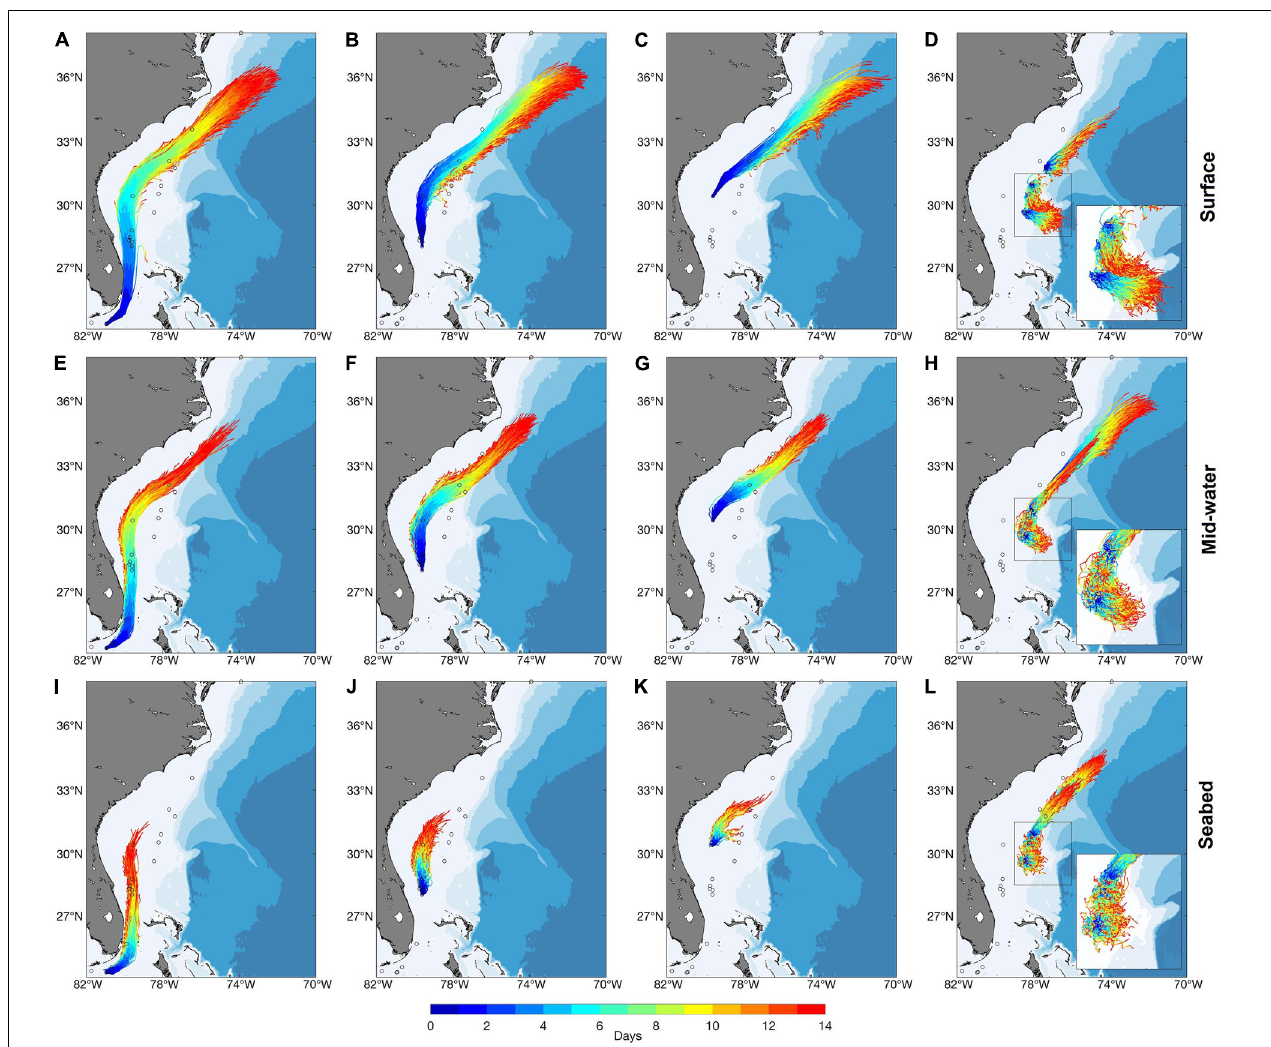
FIGURE 5 | Trajectories of particles released from occupied grid cells in Groups 1, 2, 3, and 4 [Groups 1 (A,E,I) , 2 (B,F,J) , 3 (C,G,K) , and 4 (D,H,L) ] at the surface (A–D) , mid-water (E–H) and the seabed (I–L) in July using long-term averaged currents, modeled with k h = 250 m 2 s − 1 . (Inset shows a close up of trajectories from Group 4 occurrences. Open circles indicate the locations of occurrence records. For results from modeling with k h = 0, see Supplementary Figure 5